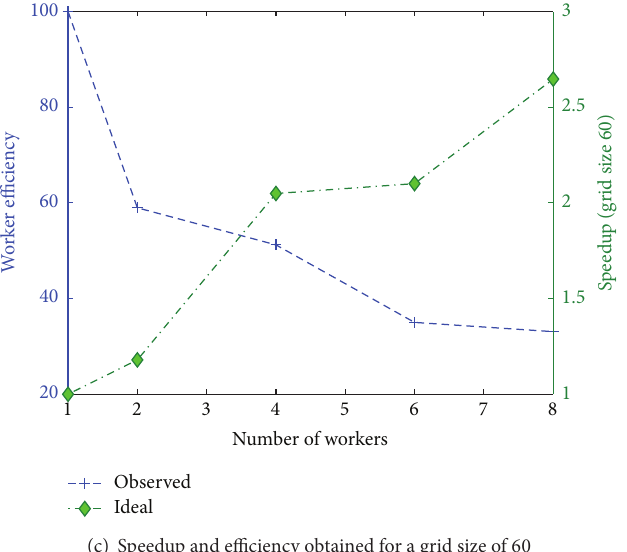
Figure 4: Plots of simulation times and obtained speedup of the PB code incorporating the SPMD construct.